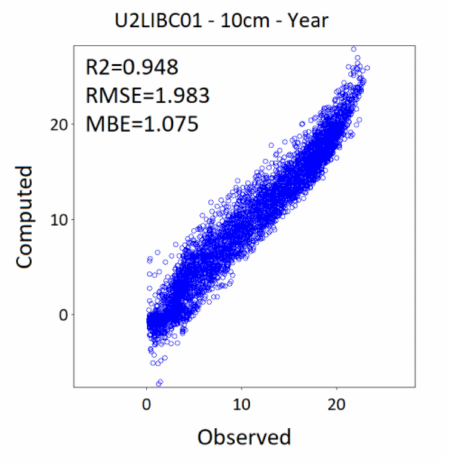
Figure A17. Validation at site U2LIBC01 for 10 cm soil